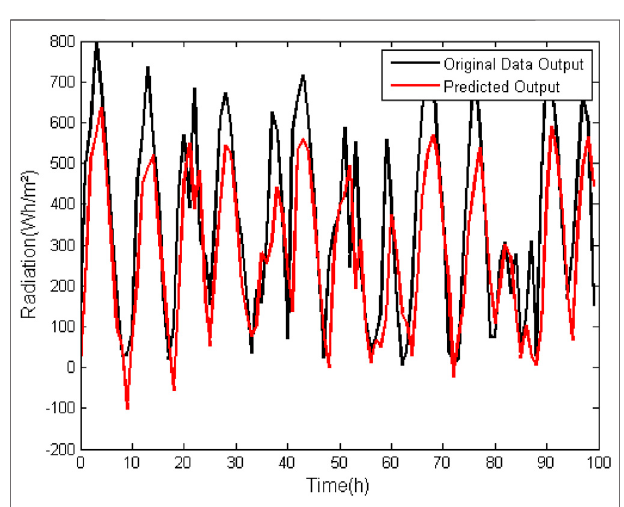
FIGURE 8 | ARMAX model (na = 5, nb = 5, nc = 5. nk = 1) for prediction of normal direct radiation data without suppression of zero.